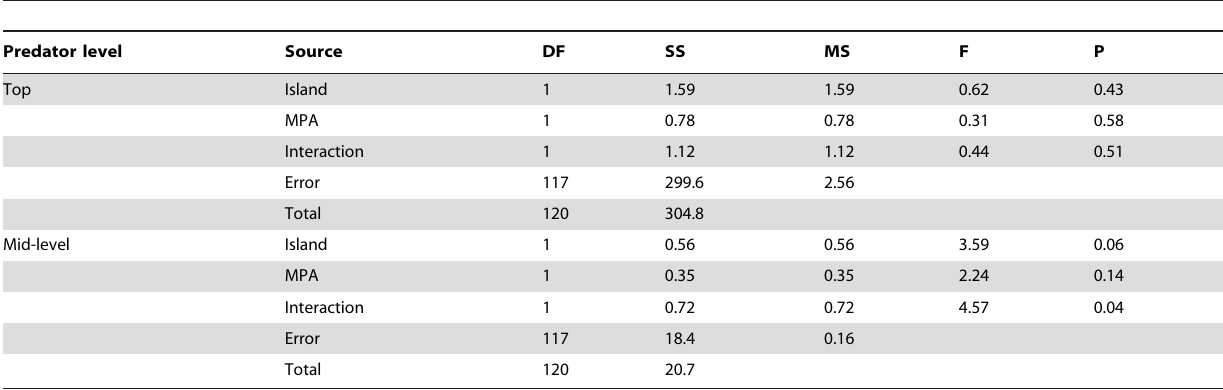
Table 4. Two-way analysis of variance of top predator and mid-level predator densities on West Hawai’i and Maui (factor Island), within and outside protected areas (MPA), and for the interaction among these fixed factors (see text for details).